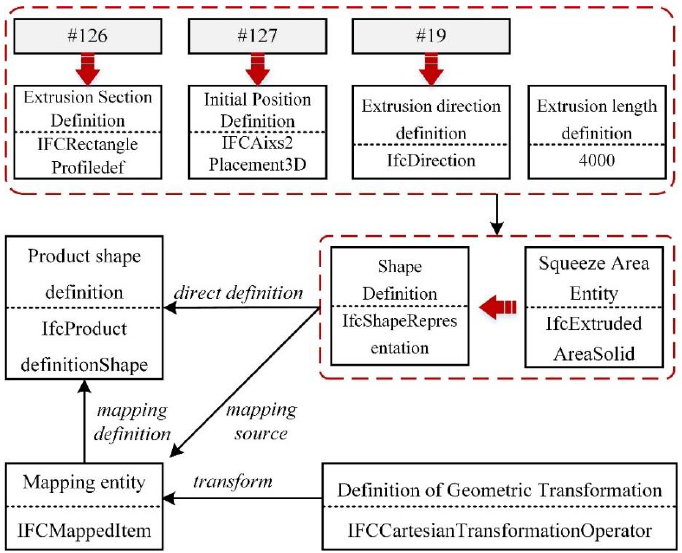
Figure 7. Example of column geometry expression.